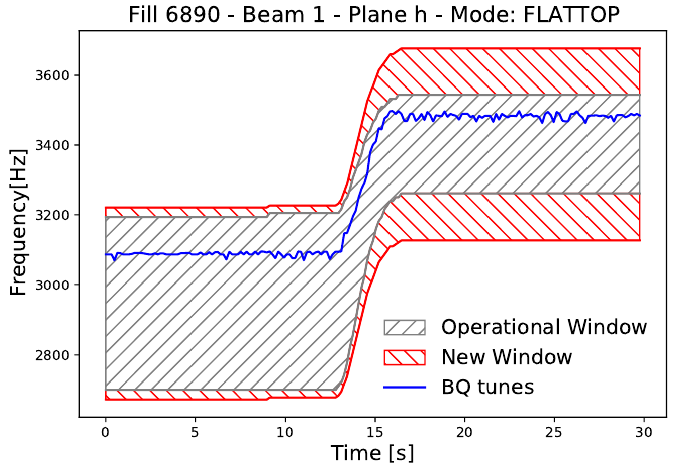
Figure 4. An example of the operational frequency windowing used by the BQ algorithm during the LHC Run 2 to the new window length used in this work. The tunes were obtained from LHC fill 6890, horizontal plane of beam 1 in the FLATTOP beam mode. During FLATTOP the optics are changed and thus the tune shifts to a new